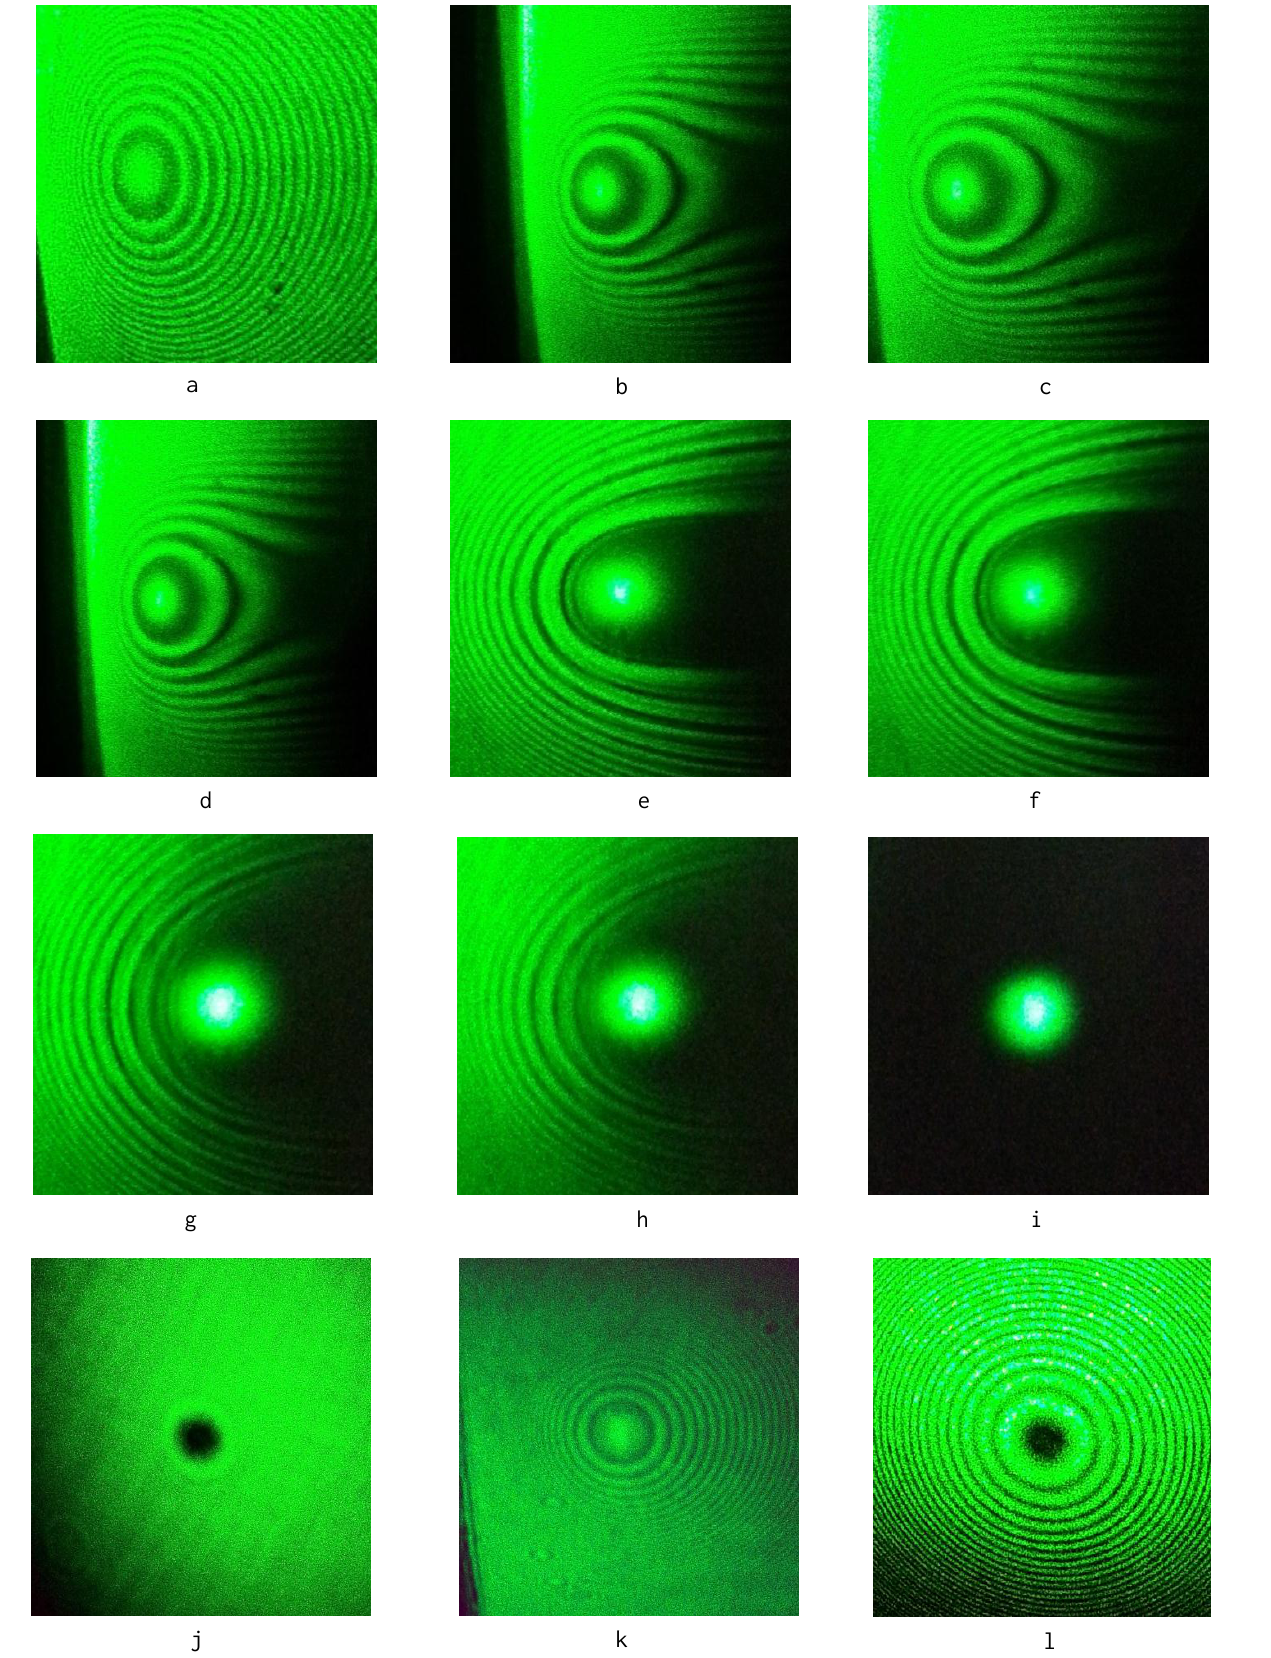
Fig. 3: Receding of Newton’s rings in the transmission (a - i) and reflection (j and l) beams upon gradual increasing of the incident angle above the critical